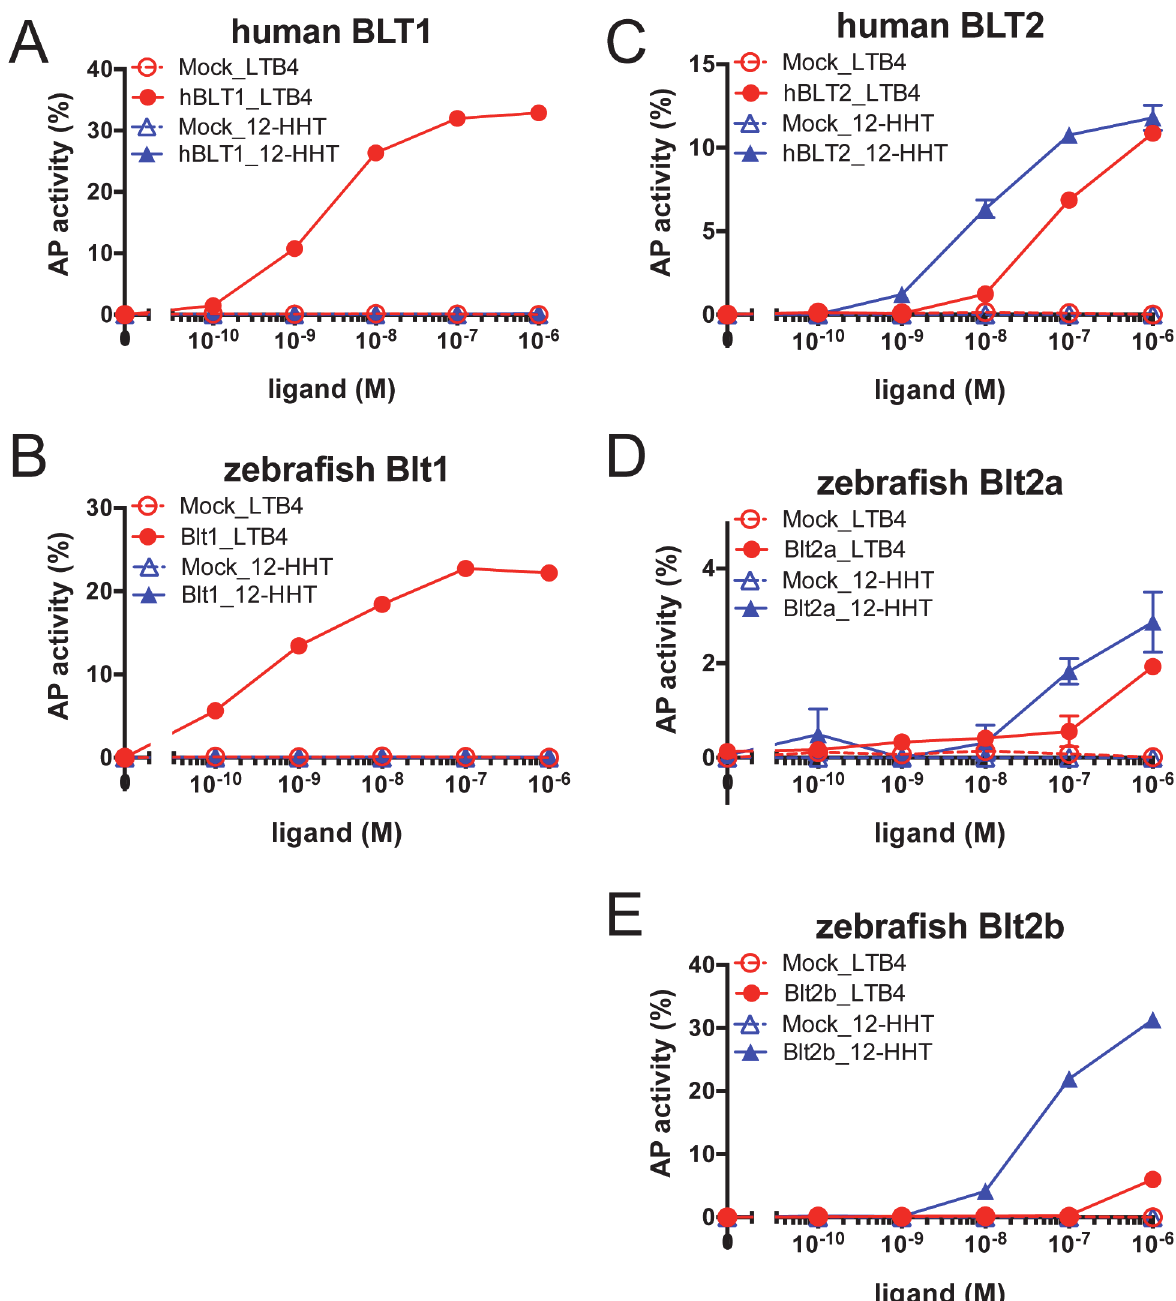
Fig 8. Ligand-dependent TGF α release via zebrafish Blt receptors. HEK293 cells expressing BLT receptors, G α q/i1 , and AP-TGF α were stimulated with LTB 4 or 12-HHT. AP-TGF α release (%) was quantified using a colorimetric AP assay using p -NPP as a substrate. Data are representative of at least two independent experiments with similar